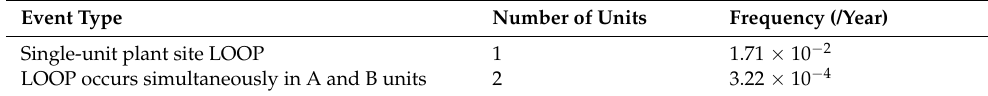
Table 4. Comparison of the frequency of LOOP event initiation events for different